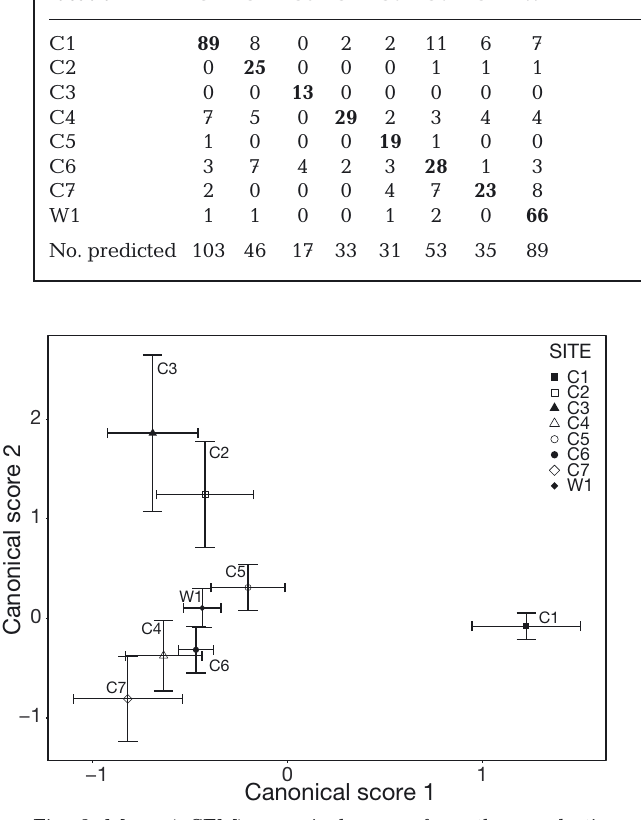
Fig. 6. Mean (±SEM) canonical scores from the quadratic discriminant function analysis examining trace element to Ca ratios in the shell material of all Perna canaliculus indi- viduals collected from monitored sites between January